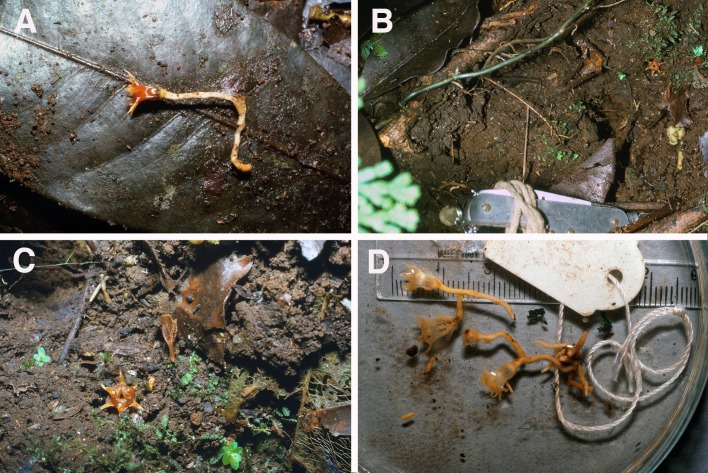
Oxygyne duncanii.(A) Whole plant, side view; (B) in habitat (penknife for scale); (C) close-up of flower in situ; (D) preserved specimens in ethanol. All photos by Martin Cheek.